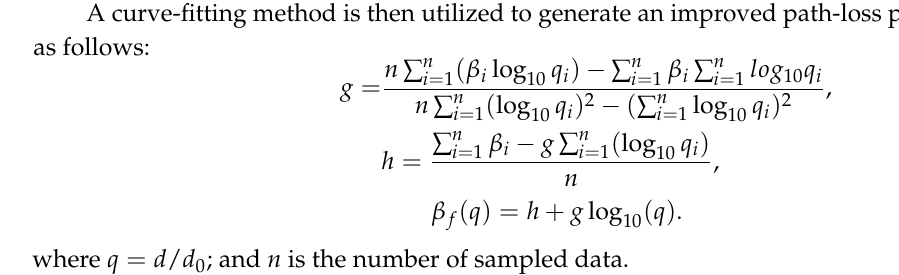
Figure 2. Experimental setup to estimate real path-loss model of the mobile